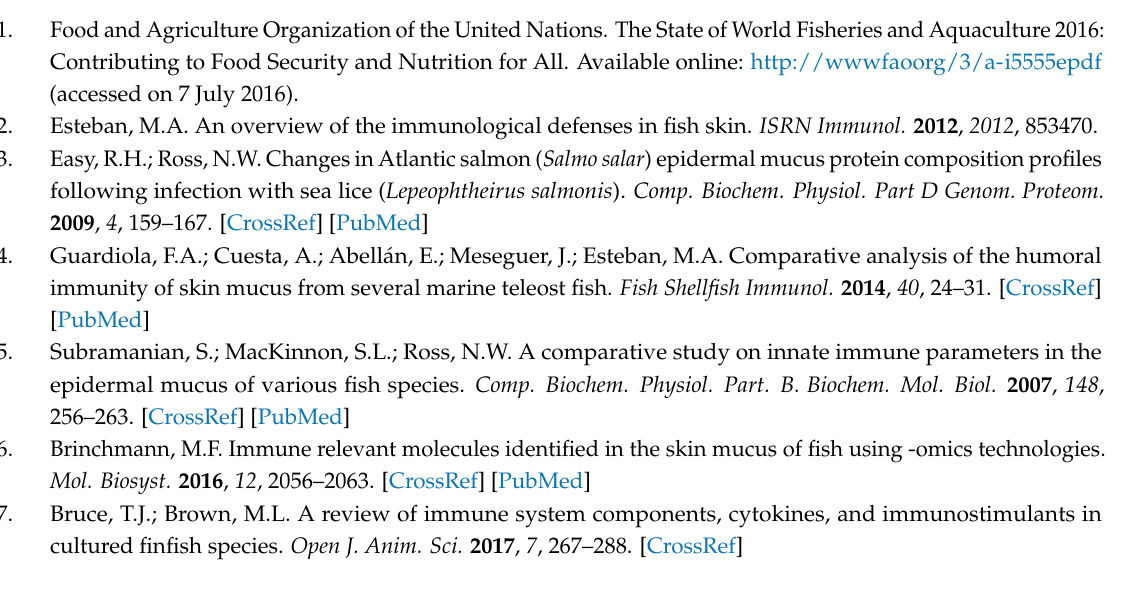
Figure S1: 3D-Score plot from principal component analysis (PCA) of the metabolite profiles obtained from untargeted LC–HRMS comparing the total variation in the mucus samples collected by scraping, wiping or absorption; Figure S2: Loading plots from PCA of the profiles of 47 metabolites in all 36 mucus samples, processed either using MZmine 2 or Xcalibur; Table S1: Complete overview over reference compounds; Table S2: LC–HRMS characteristics of all 89 small metabolites; Table S3: MZmine 2 processing parameters